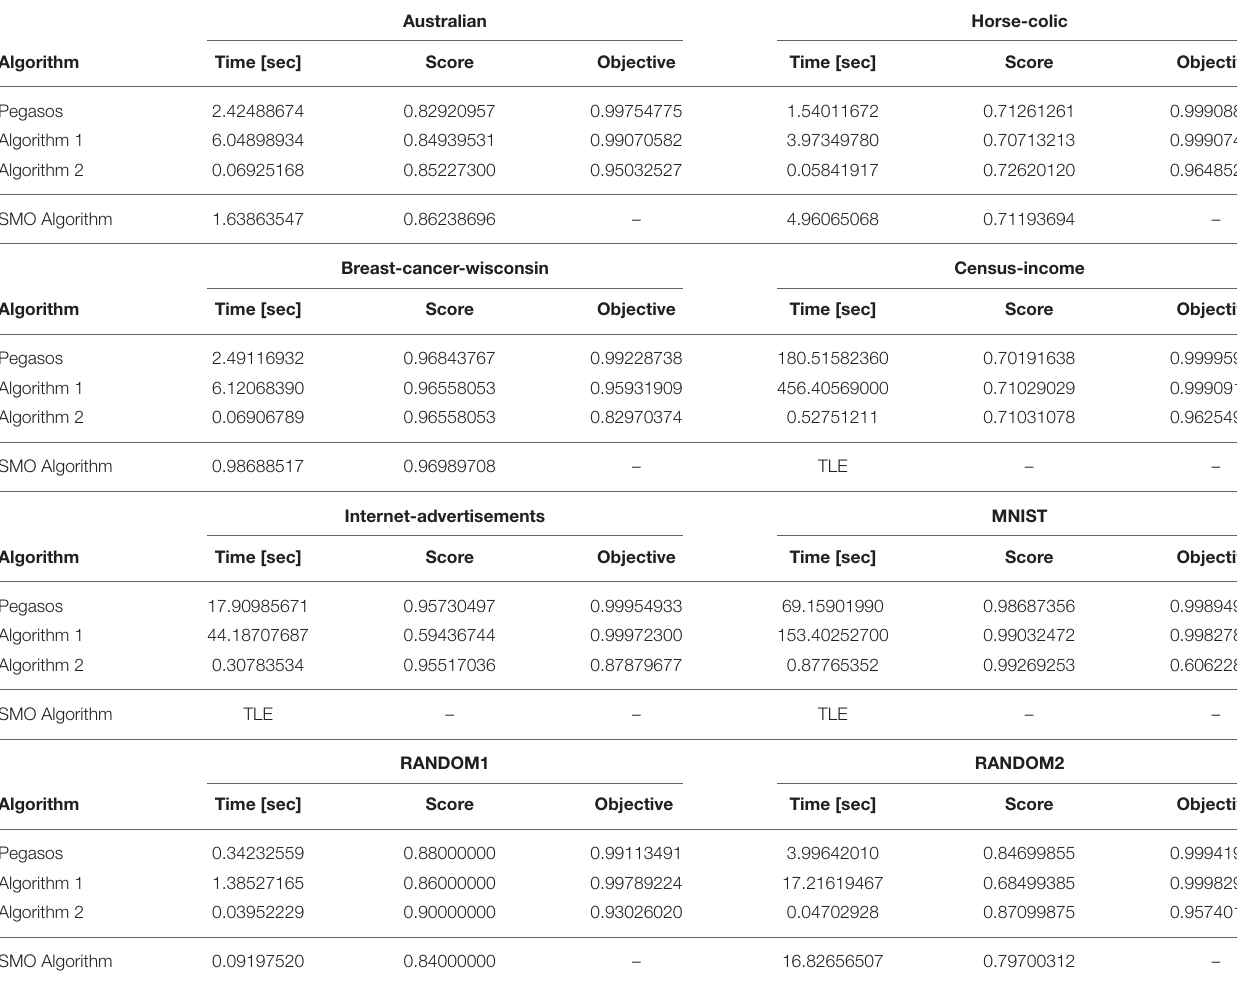
Algorithm 1, Algorithm 2, and the SMO Algorithm in terms